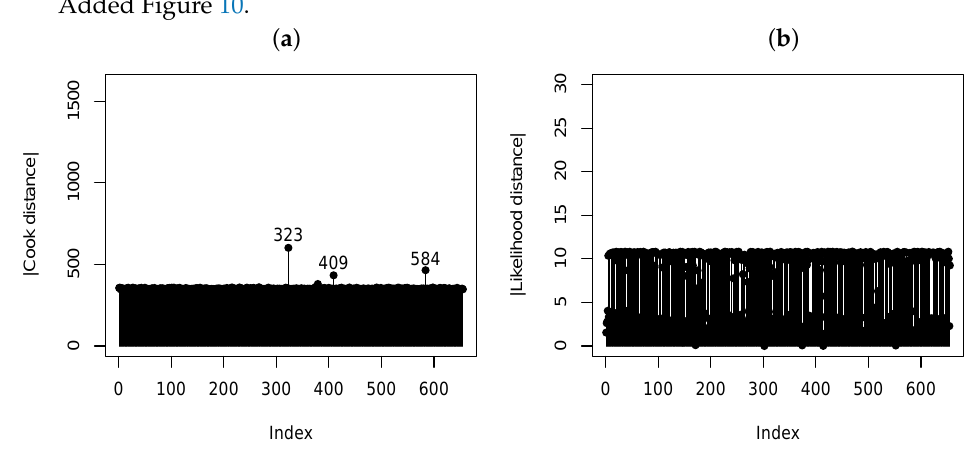
Figure 10. Index plots for: ( a ) GD i ( θ ) and ( b ) LD i ( θ )